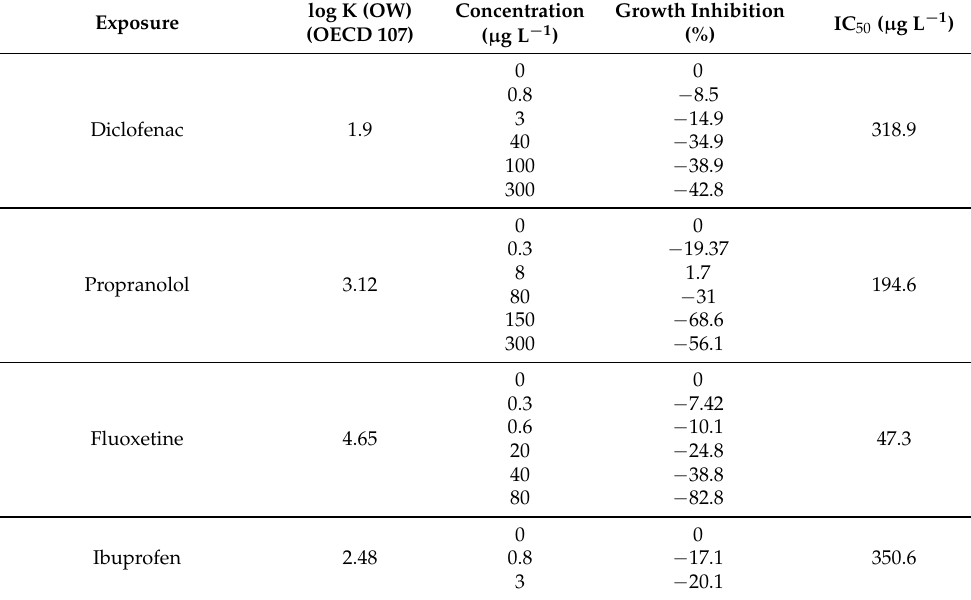
Table 2. Octanol–water partition coefficients (log KOW; NA—not applicable) and concentrations applied of the tested compounds, and respective growth inhibition (%, negative values indicate growth inhibition) and half-maximal inhibitory concentration (IC 50 ) assessed for each exposure trial